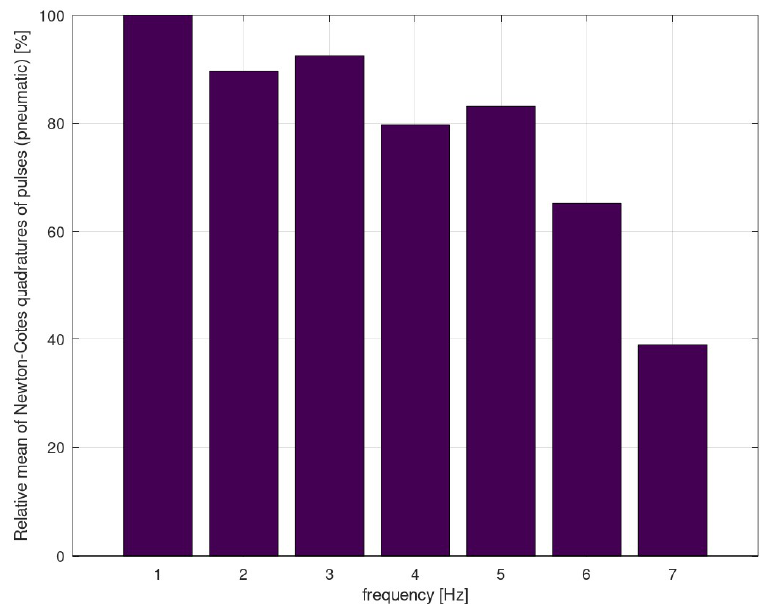
Figure 7. Energy flux density (expressed as quadrature of pulse) and the operating frequency for pneumatic applicator—measured by vibrometer.